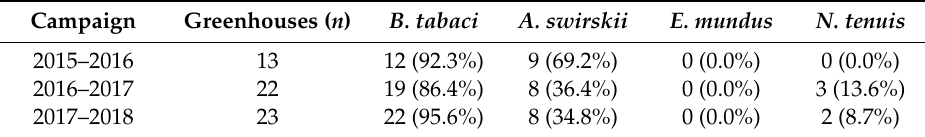
Table 2. Number (% of total) of zucchini crops with whitefly ( Bemisia tabaci ), commercial release of Amblyseius swirskii and naturally occurring parasitoid and predator ( Eretmocerus mundus and Nesidiocoris tenuis ) on more than 5% of plants.